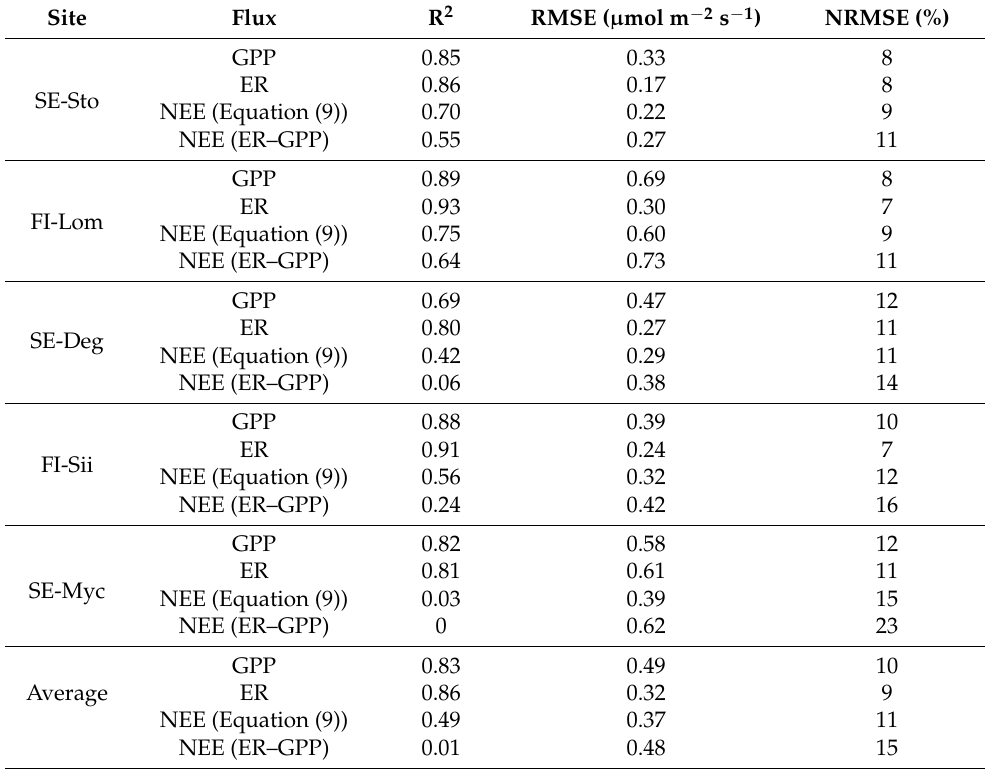
For ER, the agreement between the LOOCV parameterized model fit (Equation (8), see Table S6 for parameters) and the EC-derived ER differed between the sites more than the GPP model fit: R 2 varied between 0.23–0.85, and RMSE was between 0.31–0.98 µ mol m − 2 s − 1 (Table 2). The NRMSE of the ER model fit was similar to that of the GPP model, varying from 10% to 20%. The ER model performed best at Siikaneva, whereas the weakest relationships were found at Abisko-Stordalen and Mycklemossen. Using site-specific parameters (Table S4), the model NRMSE was reduced to between 7–12% of the flux range for both the GPP and ER estim- ates (Table 3). Table 3. Goodness-of-fit statistics for the site-specific GPP, ER and NEE models, for all available site years. NRMSE is RMSE normalized using the range (maximum–minimum) of the EC-derived